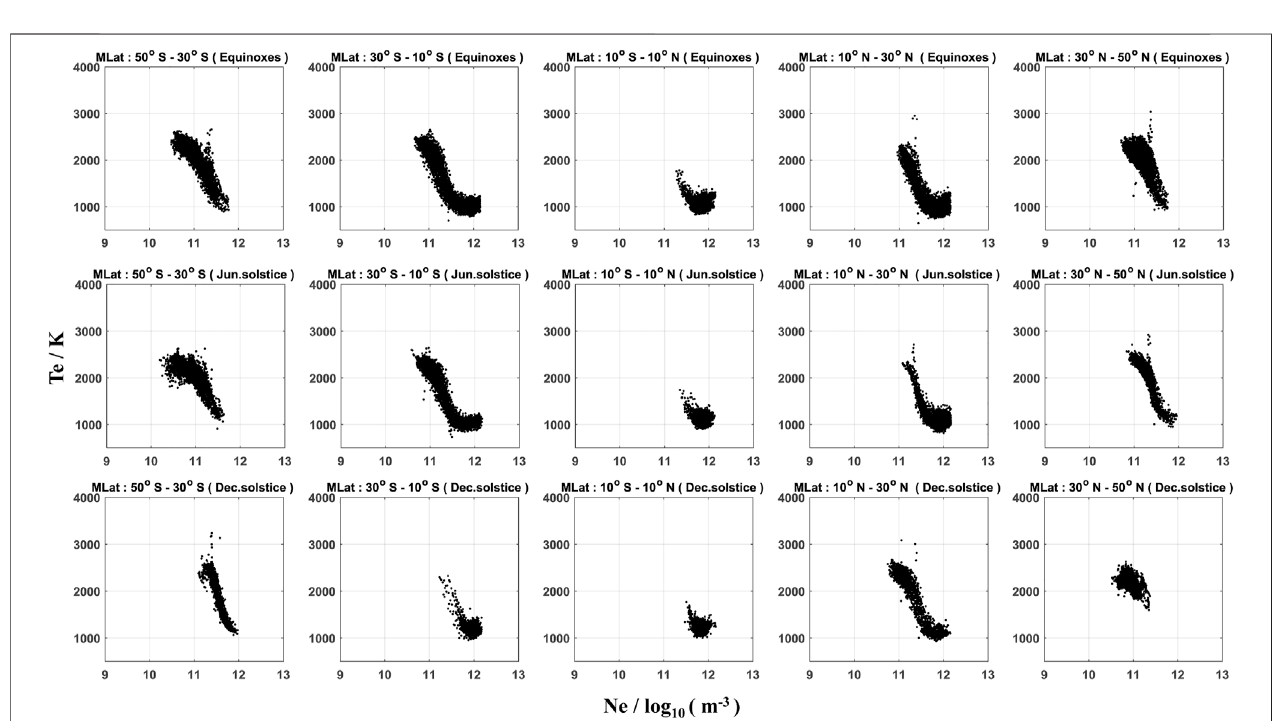
FIGURE 8 | As same as for Figure 5 , but for CHAMP.